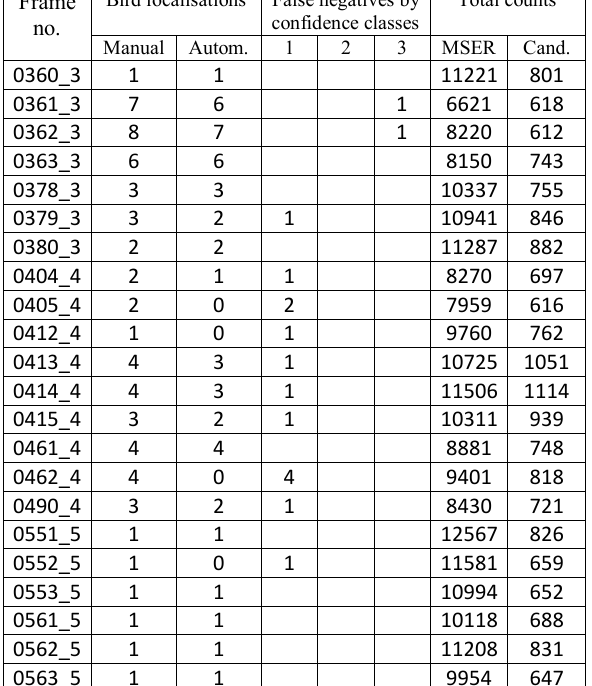
Table 2. Filter accuracy assessment for the image set taken from the northern part of the parallel survey. Due to the coarser GSD of 0.03m, the discriminatory power of the filter is much lower than in the set with GSD of 0.02m. This is manifested by higher counts of candidates and higher under-estimation